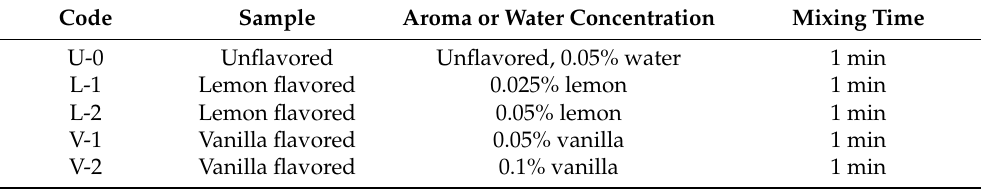
Table 1. Yogurt samples, added aroma or water concentration, and mixing